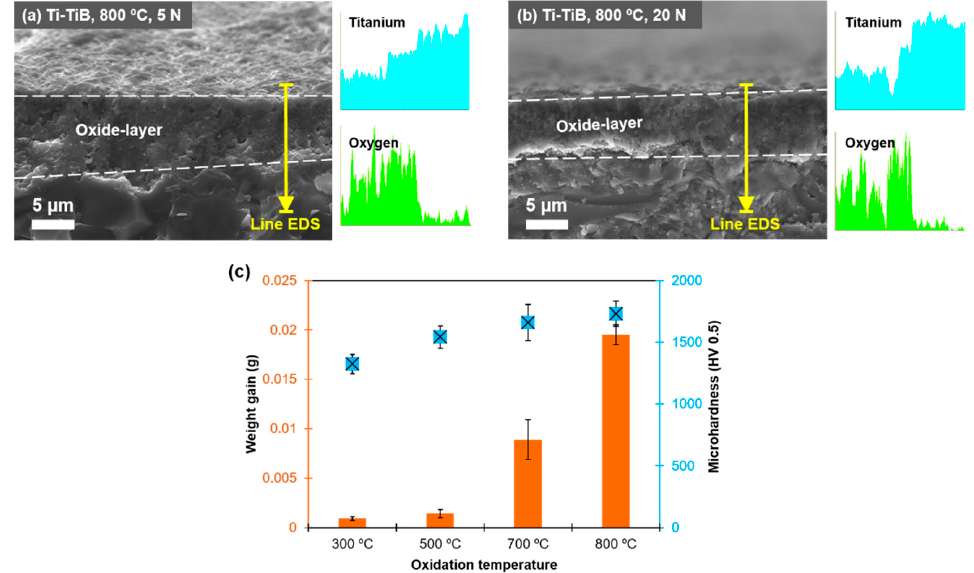
Figure 8. ( a,b ) SEM images of a central part of wear track cross-section of the composites tested at 800 °C with load of 5 or 20 N; ( c ) effect of oxidation temperature on weight gain and microhard- ness of composite. of